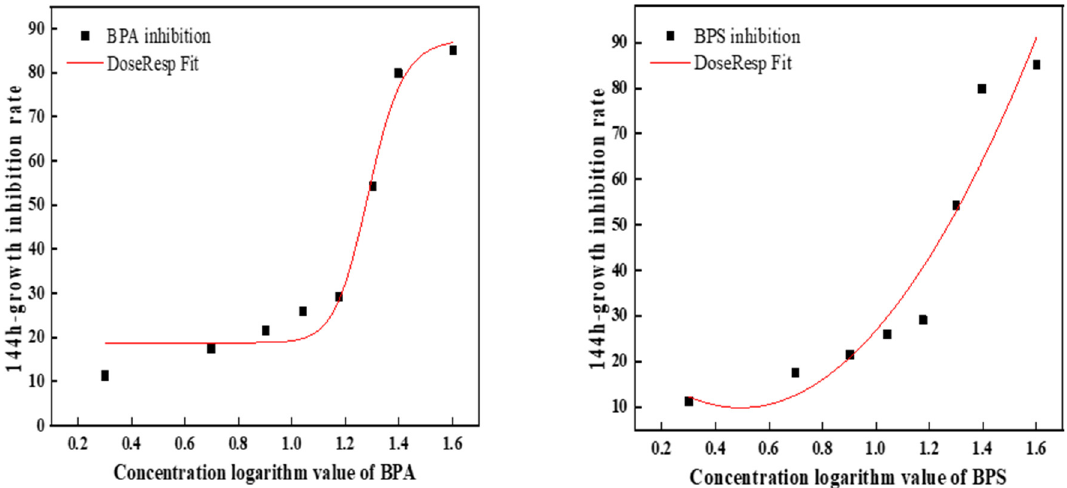
Figure 2. The fitted curve of the 144 h EC 50 of BPA and BPS. Table 2. Adjustment results of the 144 h joint toxicity test.